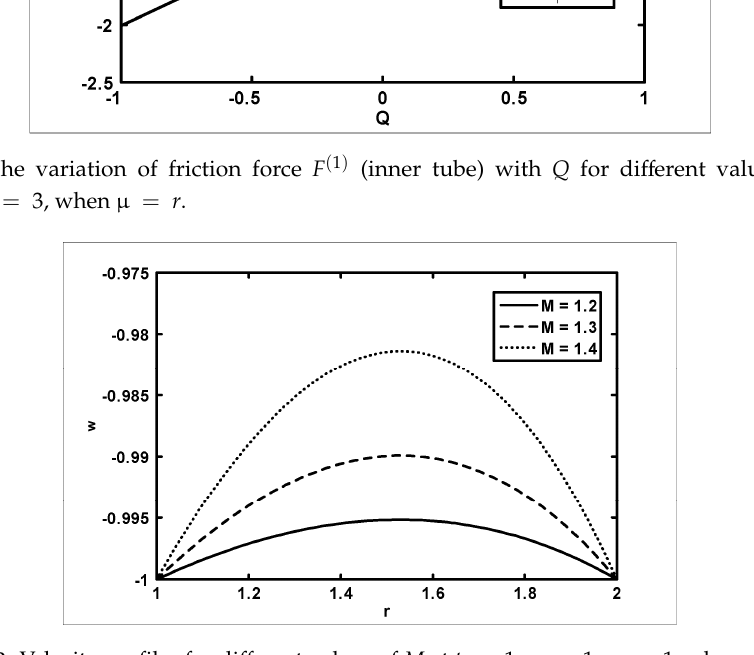
Figure 9. Velocity profiles for di ff erent values of M at t = 1, z = 1, ϕ = 1, when µ = r